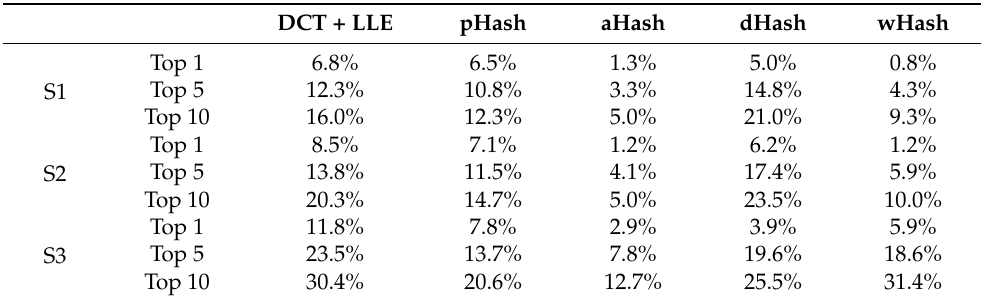
Table A1. Correct matches results for database vs. TS1 comparison—without Radon transform or contrast stretching application (256-bit).